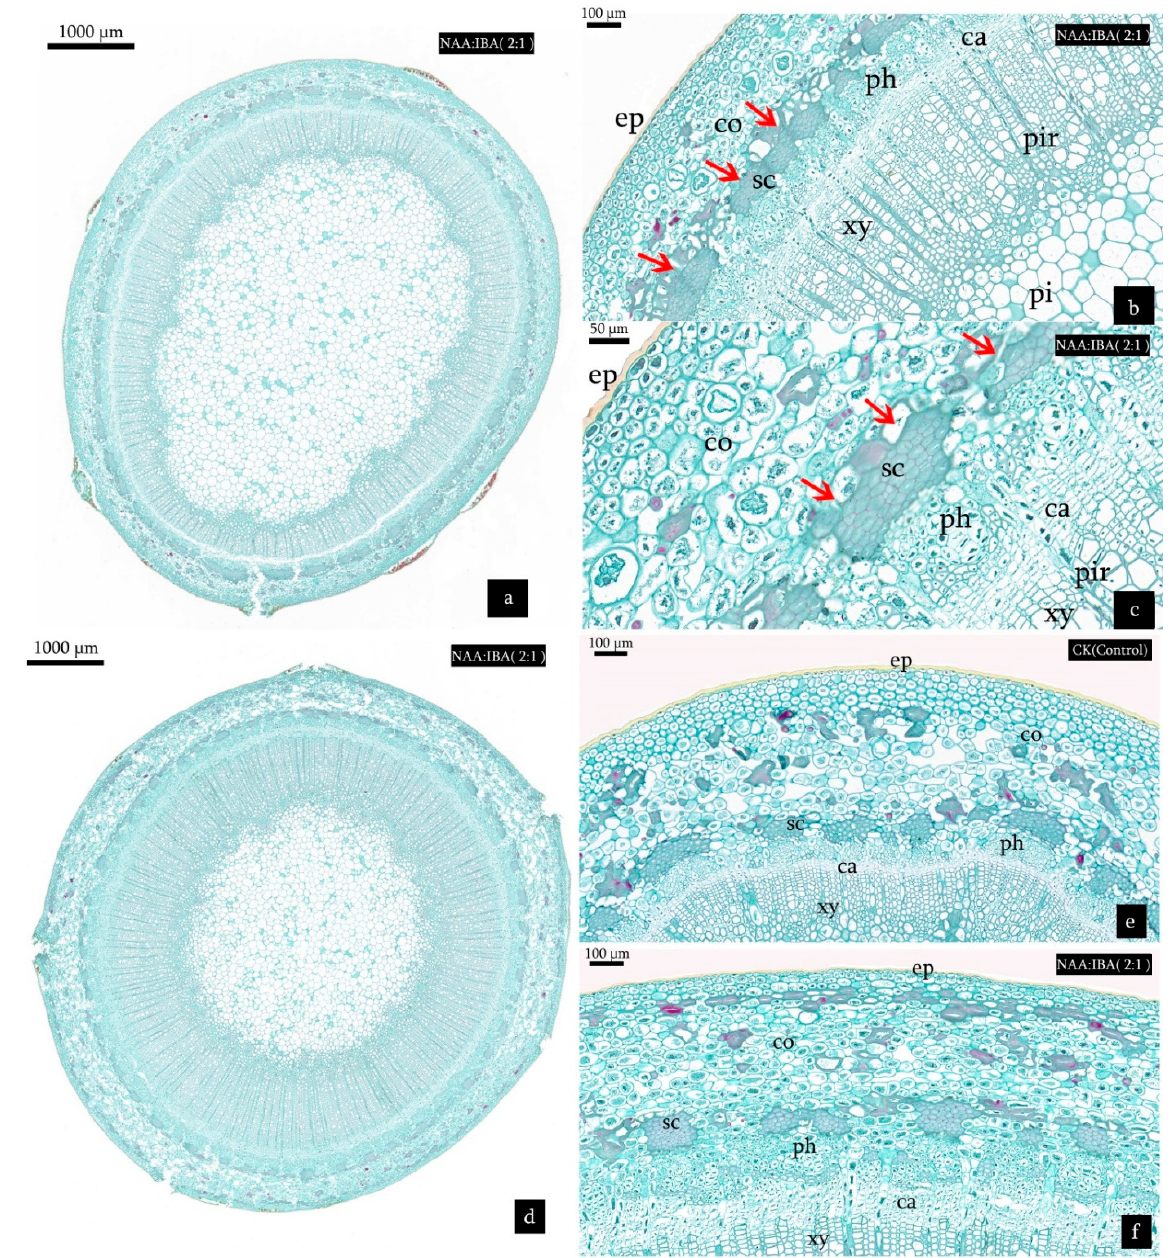
Figure 5. Transverse sections derived from cuttings on day 0 and 8 after planting. ( a ) Histological structure of cutting treated with NAA:IBA (2:1) on day 0 after planting. ( b , c ) Close-up images of histological structures of cuttings treated with NAA:IBA (2:1). Arrow showing the ring of sclerenchyma. ( d ) Histological structure of the cutting treated with NAA:IBA (2:1) on the 8th day after planting. ( e ) Transverse sections derived from cuttings in CK (Control) on the 8th day after planting. ( f ) Transverse sections derived from cuttings treated with NAA:IBA (2:1) on the 8th day after planting, showing the thickening of cortex, phloem, and cambium areas. Abbreviations: ep = epidermis; co = cortex; sc = sclerenchyma; ph = phloem; ca= cambium; xy = xylem; pi = pith; pir = pith ray.